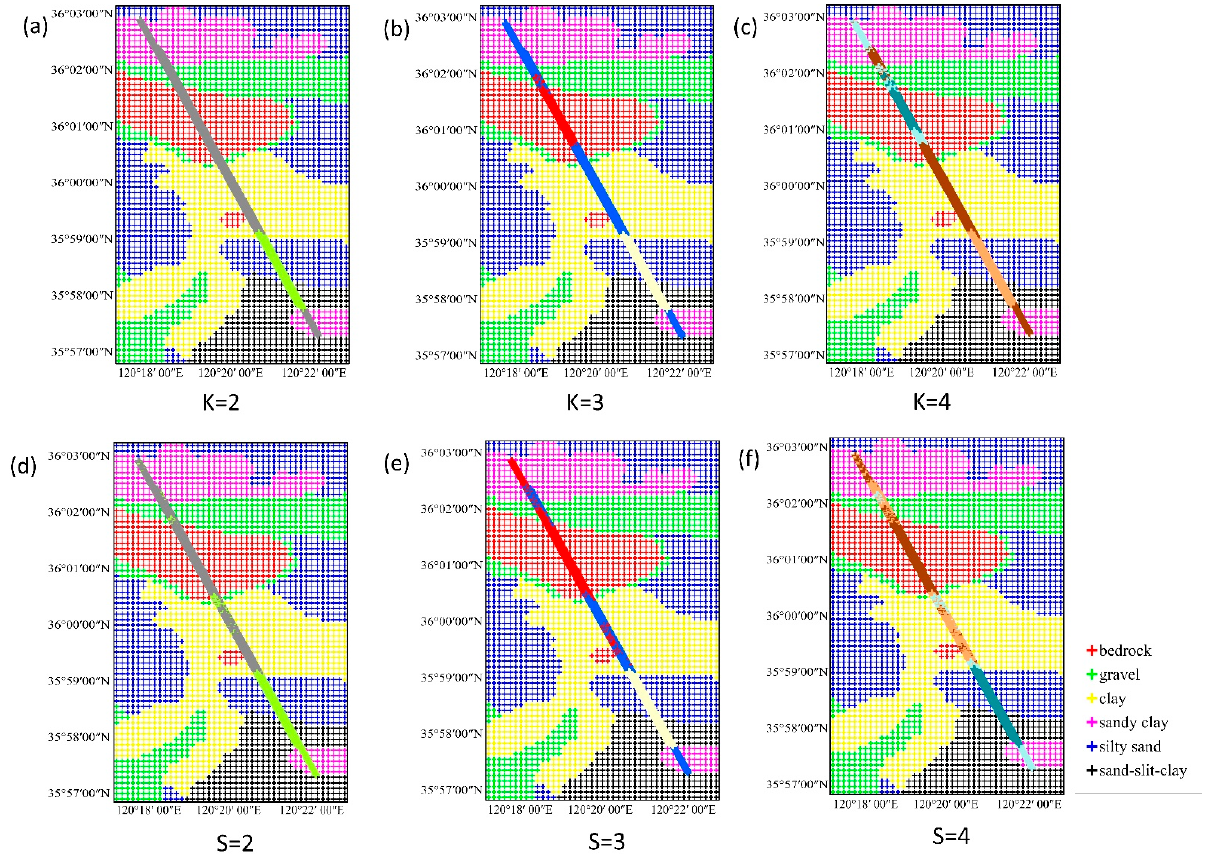
Figure 9. The classification results of K-medoids under: ( a ) two categories; ( b ) three categories; ( c ) four categories, and the classification results of SOM under: ( d ) two categories; ( e ) three categories; ( f ) four categories.